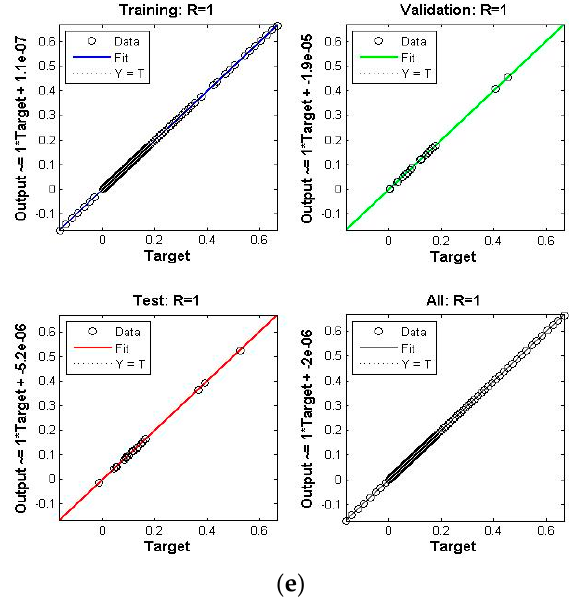
Figure 5. Scenario II Case I of TD-PNFM. ( a ) MSE Results: Scenario II Case I; ( b ) Transition state: Scenario II Case I; ( c ) Fitness: Scenario II Case I; ( d ) Error Histogram: Scenario II Case I; ( e )regression: Scenario II Case I.